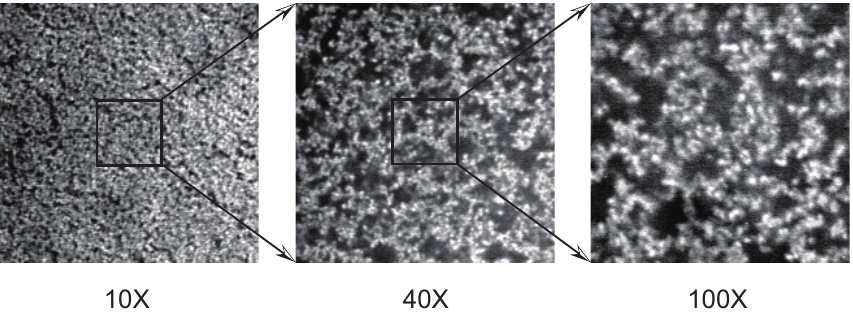
Figure 9. The confocal laser scanning microscope (CLSM) images of opaque PAAm gel. The magnification of the image is 10 × , 40 × , and 100 × from left to right. The length of the side of these images is 189 µ m, 48.8 µ m, and 18.9 µ m from left to right. The concentrations of AAm and N,N -methylenebisacrylamide (BIS) are 350 mM. The total concentration is 700 mM and the mole fraction of BIS is 50%. The squares in the image of 10 × is the observation area of 40 × observation. The square in the image of 40 × is the observation are of 100 × observation. These squares only show the relative size of the images and are shown only for a guide to the